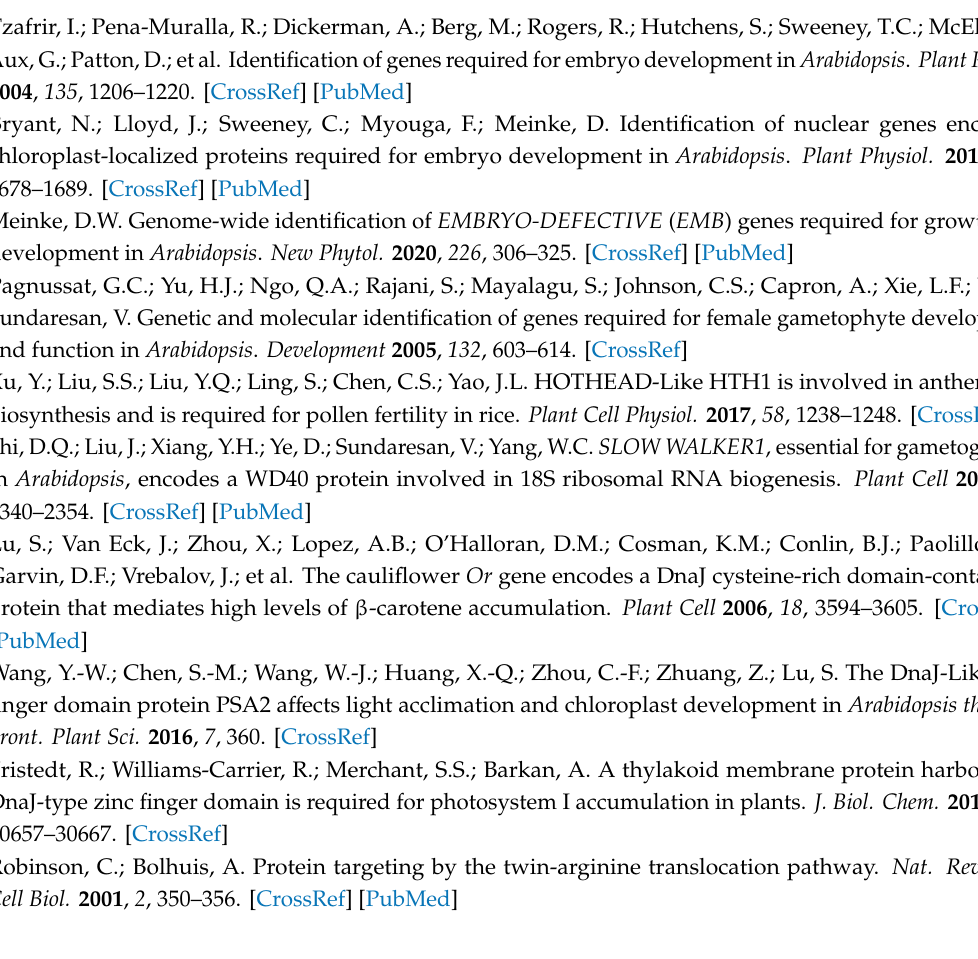
Figure S1: Phenotype of the eda3 mutant, Figure S2: Deduced amino acid sequence of EDA3, Figure S3: Validation of the antibody against EDA3, Figure S4: Sequences of EDA3, ORANGE, TsiP1, and ANGULATA